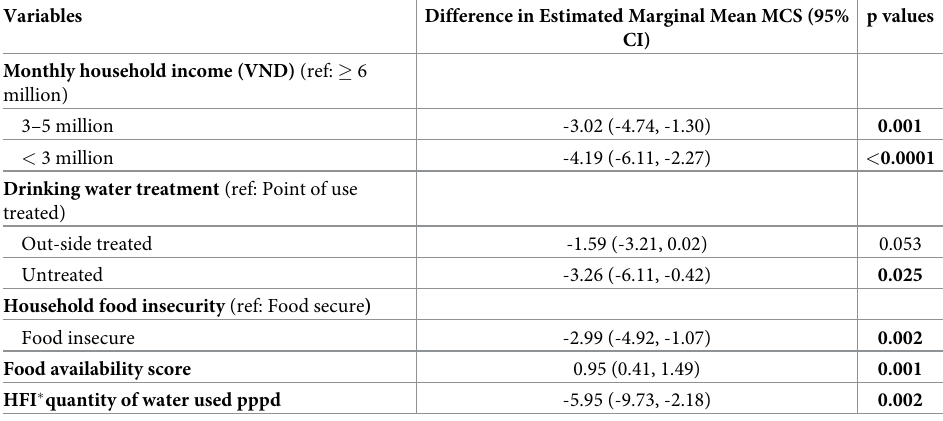
Table 4. Factors associated with MCS in multivariable general linear